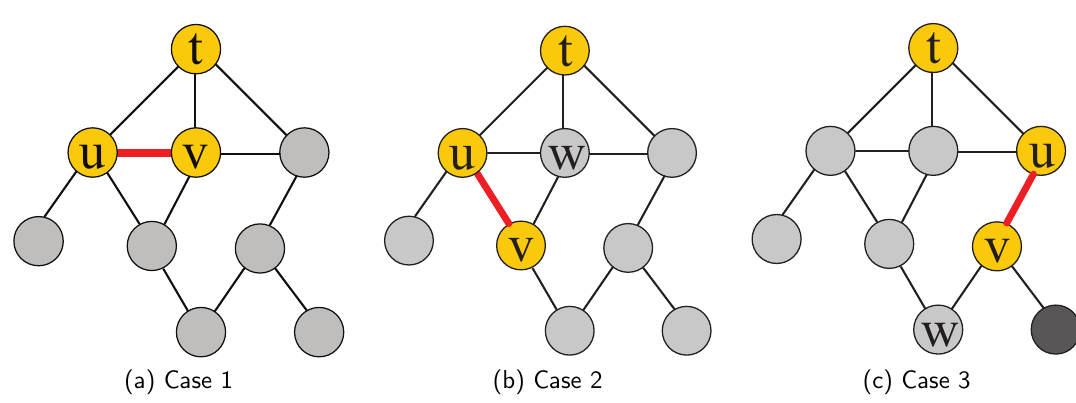
Figure 3. Three cases of the edge deletion.